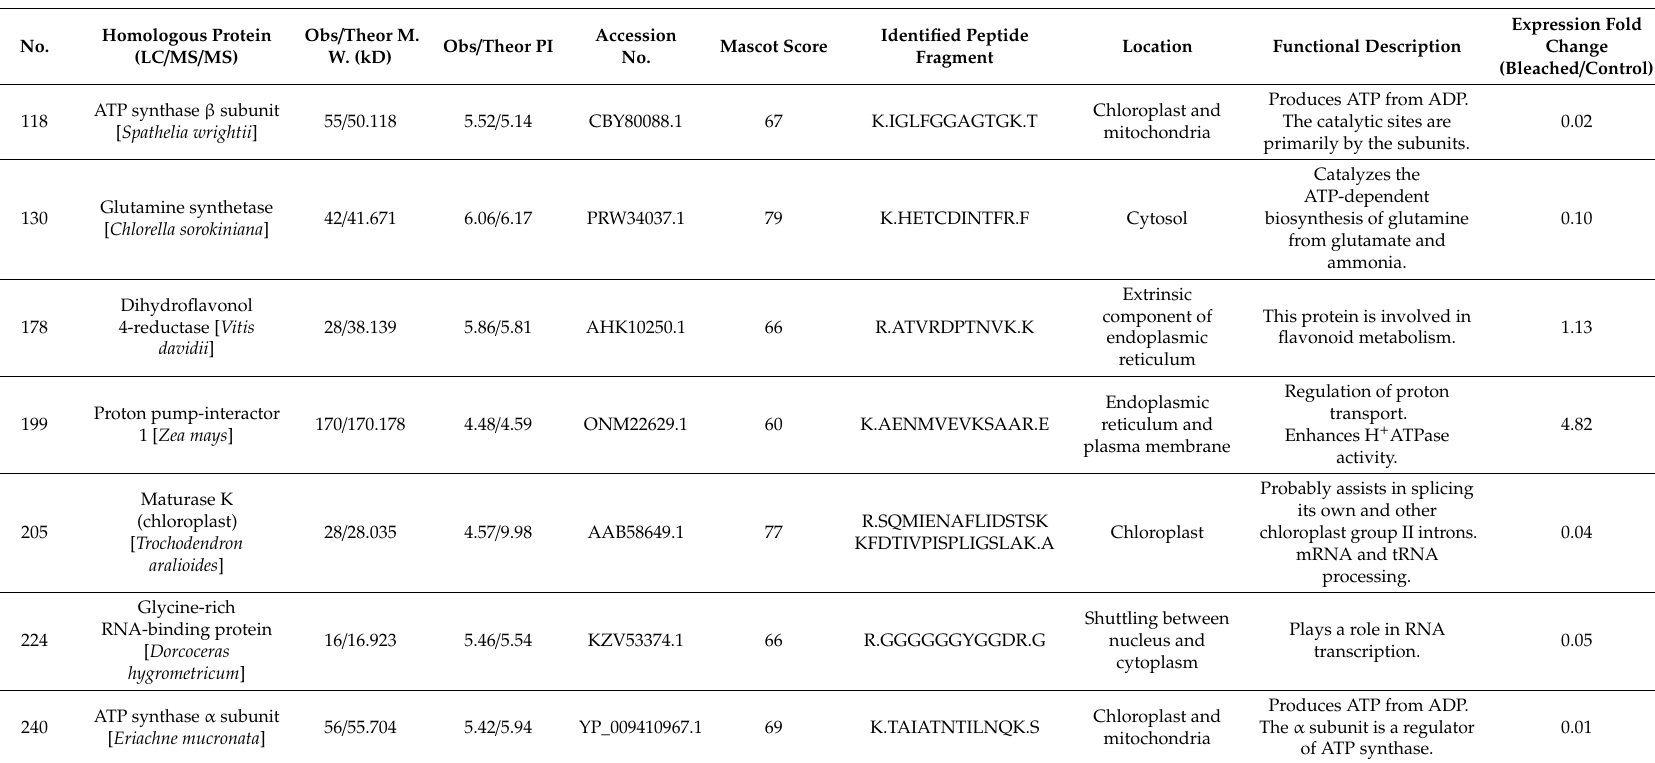
Table 1. List of identified proteins from S. vacuolatus using liquid chromatography–tandem mass spectrometry (LC-MS /